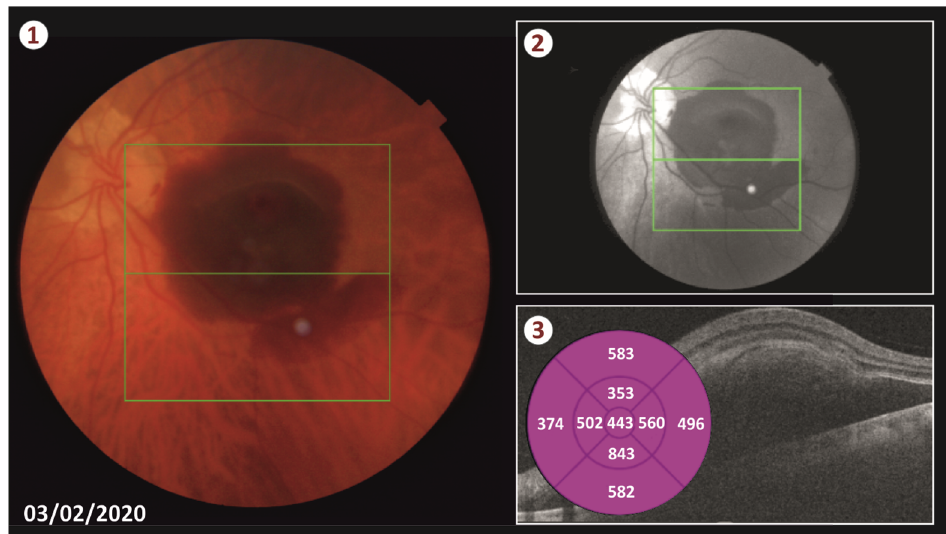
Figure 1. Fundus picture (photos 1 and 2) of the patient’s left eye at first visit. A large submacular hemorrhage due to AMD is shown. The OCT (photo 3) indicates a CMT of 443 μ m.